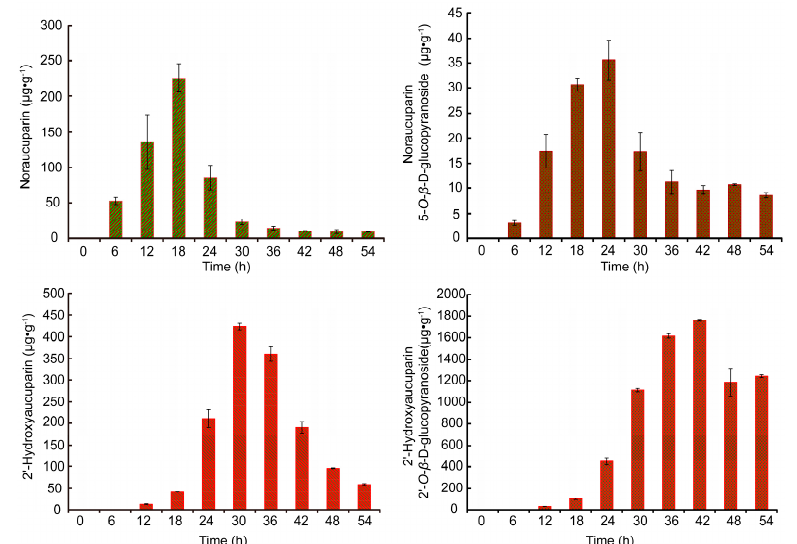
Figure 7. Time course of biphenyl and its glycoside production of S. pohuashanensis suspension cells after YE treatment. Values are means of three independent experiments. Bars represent standard errors.